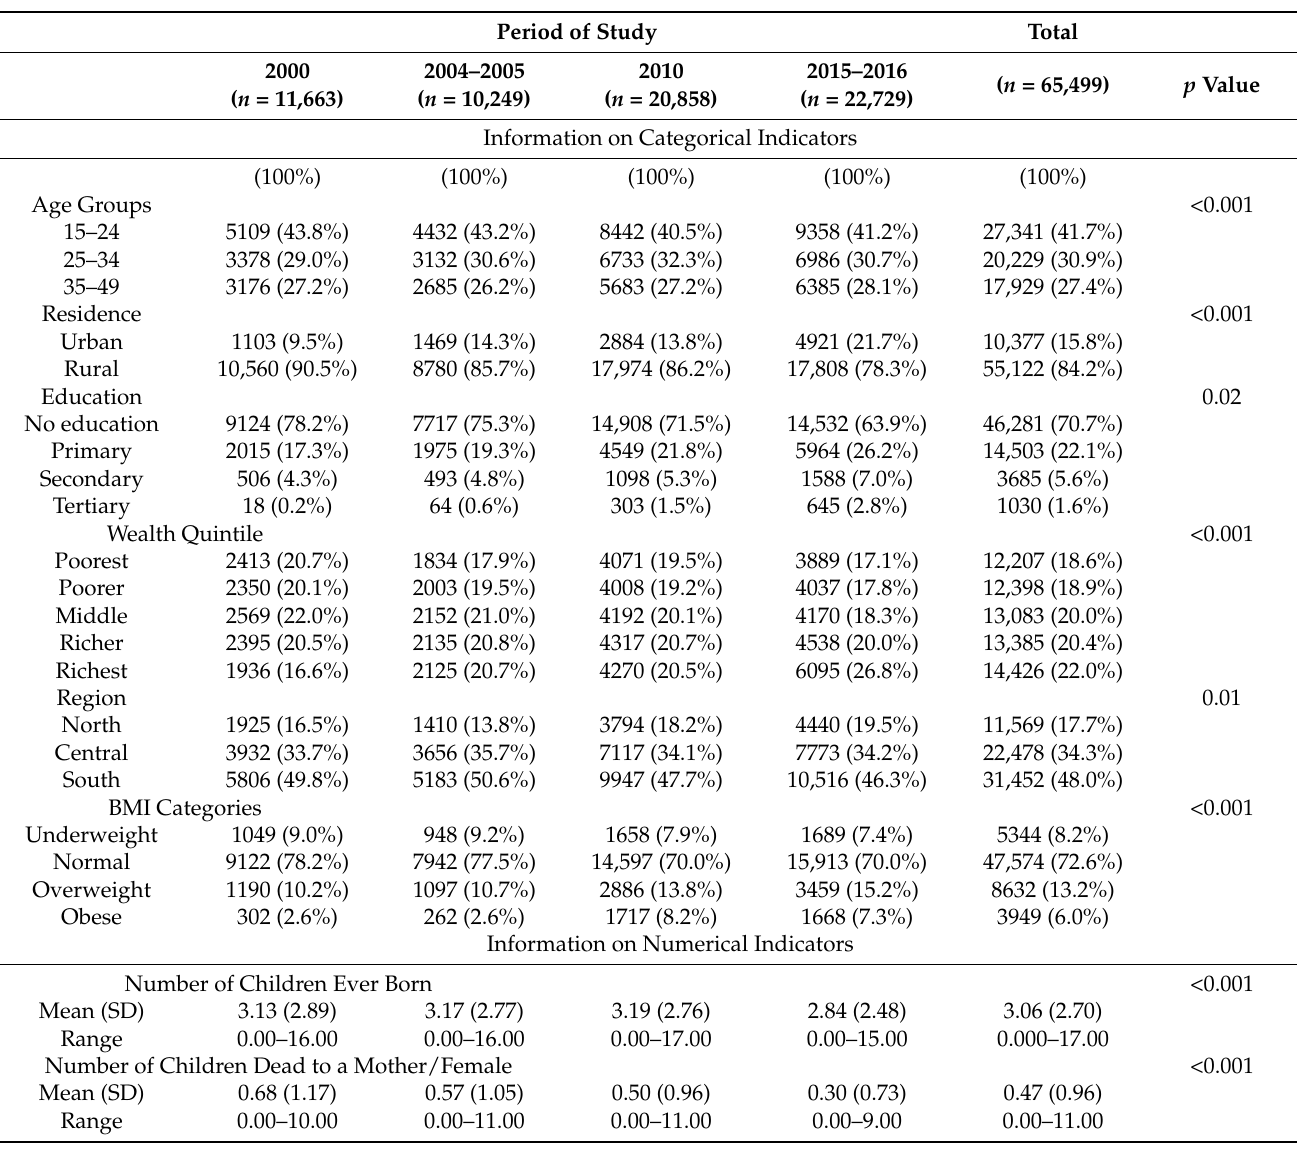
Table 2. Sociodemographic profiles of females in Malawi from 2000 to 2015–2016. Period of